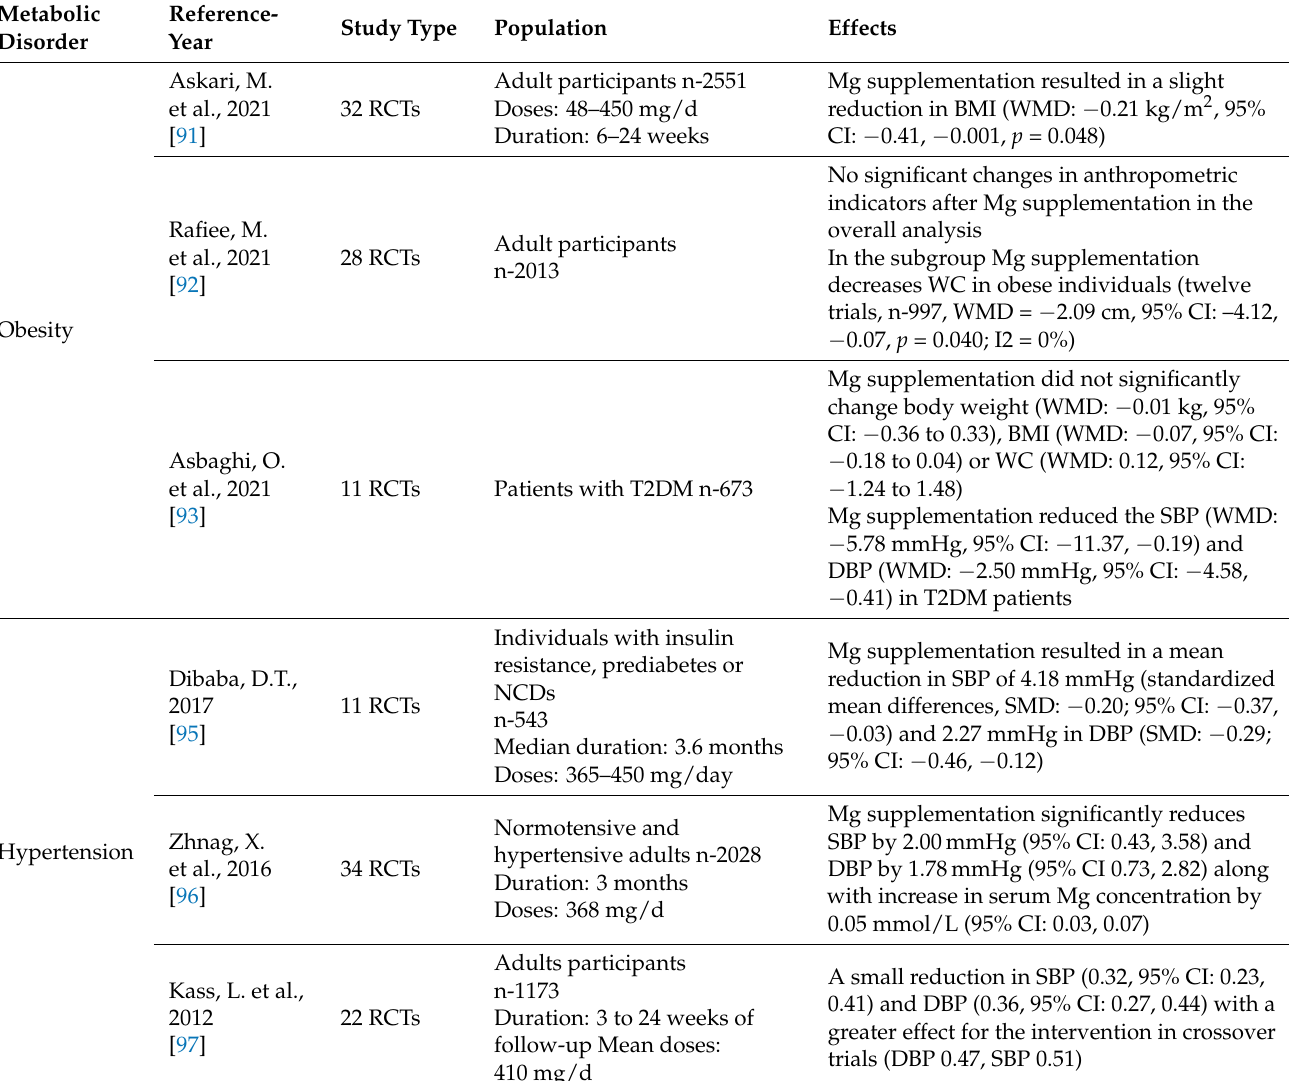
Table 4. Magnesium supplementation in management of MetS components—the reviews of